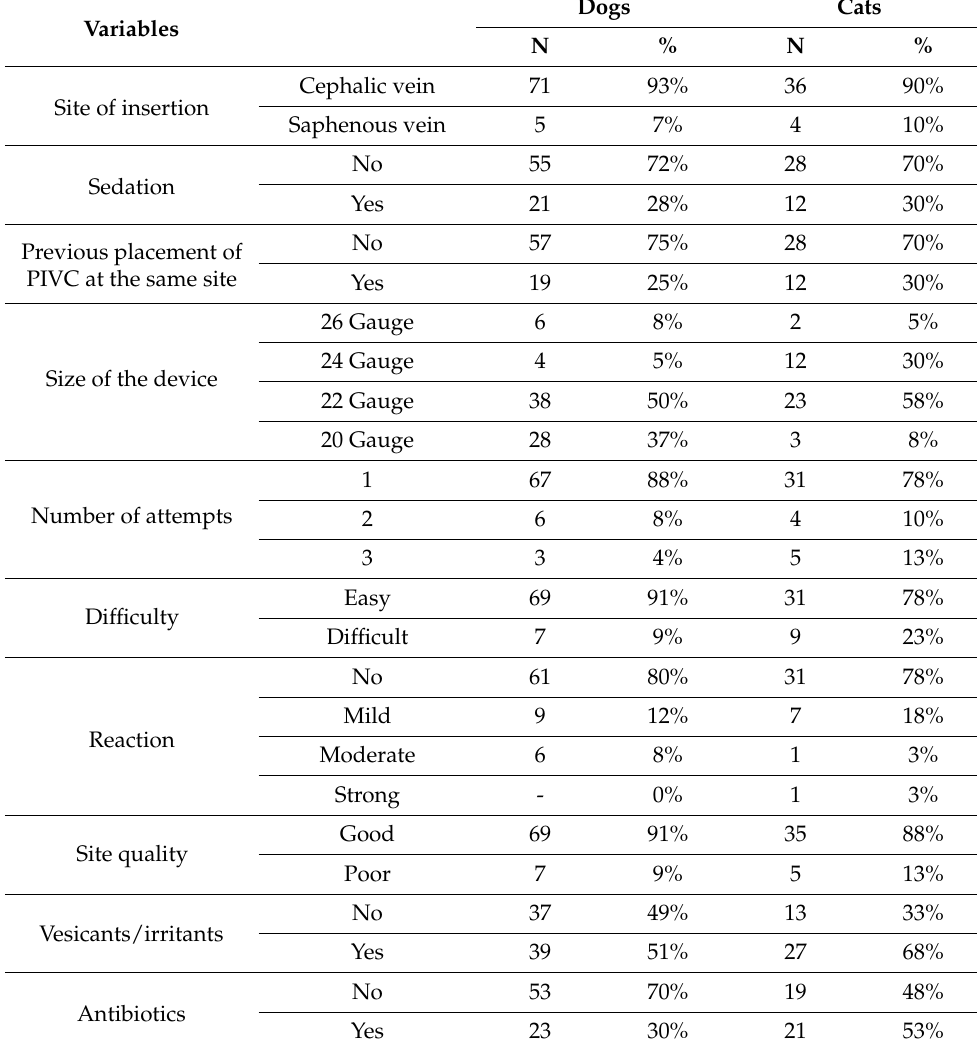
Table 2. Results on the insertion procedure of intravenous catheters and administration of irritant and/or vesicants and antibiotics.